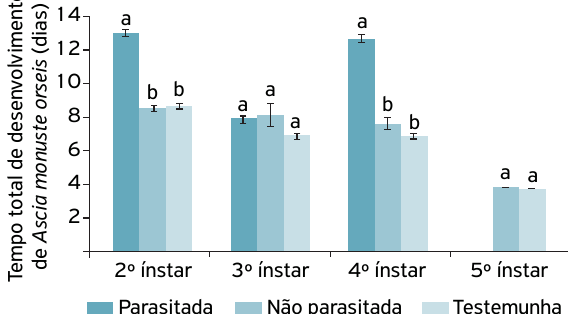
Figura 2. Duração total (dias ± EP) da fase larval de Ascia monuste orseis após o parasitismo, nos diferentes ínstares, por Cotesia glomerata